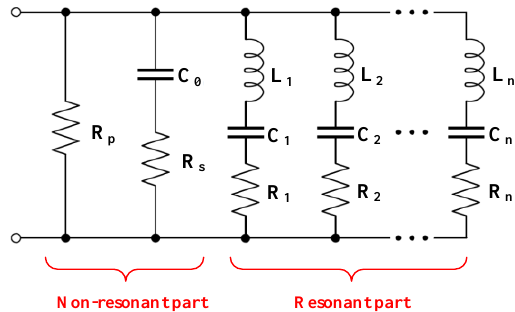
Figure 1. Electrical equivalent model of piezoelectric element.